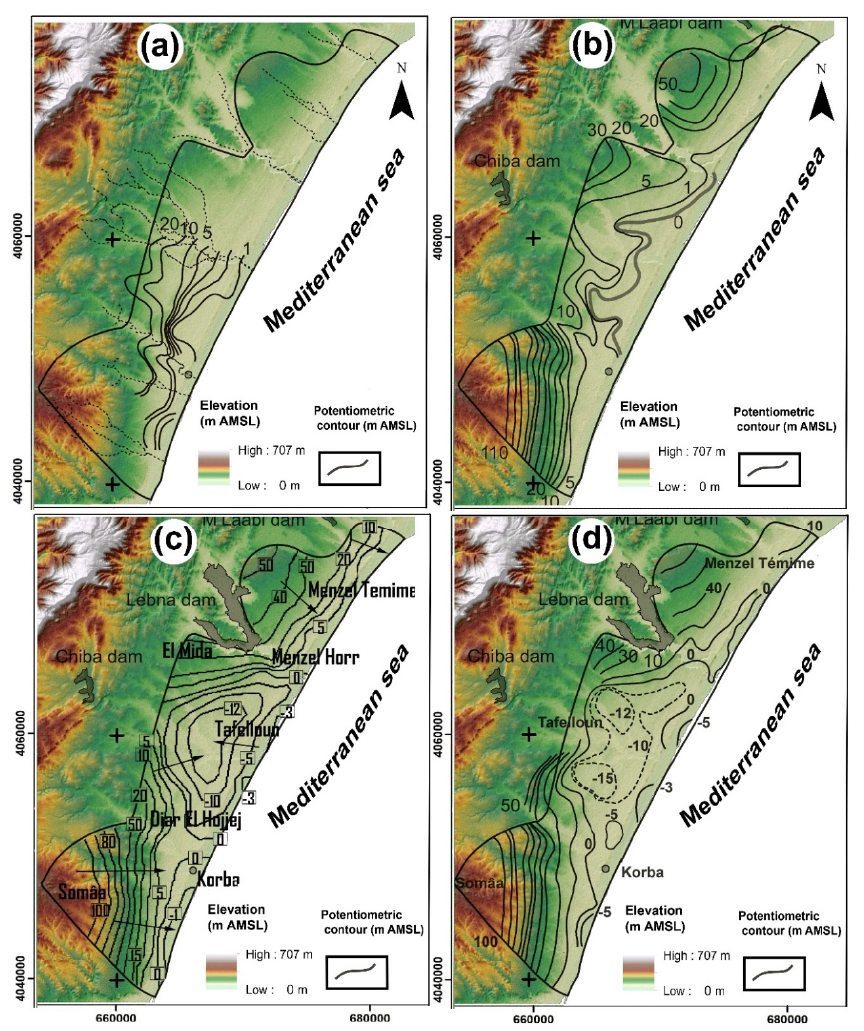
Figure 3. Potentiometric map evolution of the Korba aquifer: ( a ) 1965 [10]; ( b ) 1977 [10]; ( c ) 2014 [8] and ( d ) 2018 (Chiba, M’Laabi and Lebna dams were built in 1963, 1964 and 1986,